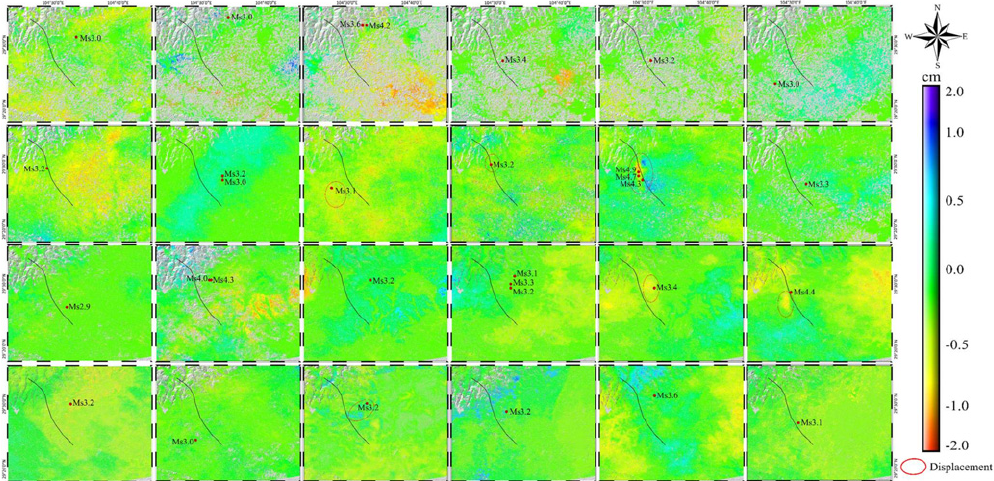
Figure 4. Earthquake displacement results after GACOS correction. The black line denotes the location of the fault, and the red dots are the